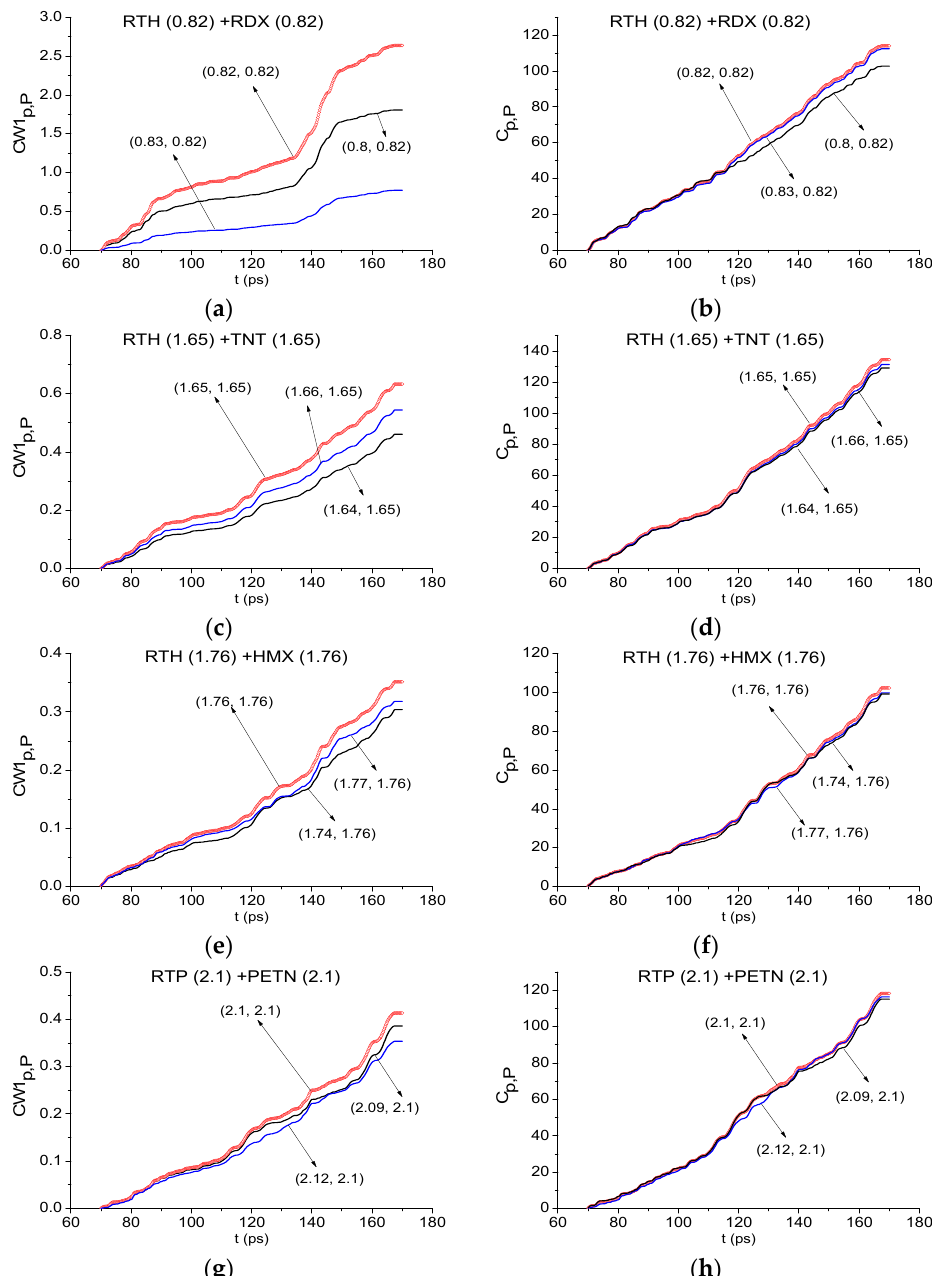
Figure 19. Time-dependent ICCs CW p , P ( a,c,e,g ) and C p , P ( b,d,f,h ) detecting the frequencies ν = 0.82 THz (RDX) ( a,b ), 1.65 THz (TNT) ( c,d ), 1.76 THz (HMX) ( e,f ) in the RTH signal and ν = 2.1 THz (PETN) ( g,h ) in the RTP signal in the time interval t = [70, 170] ps.